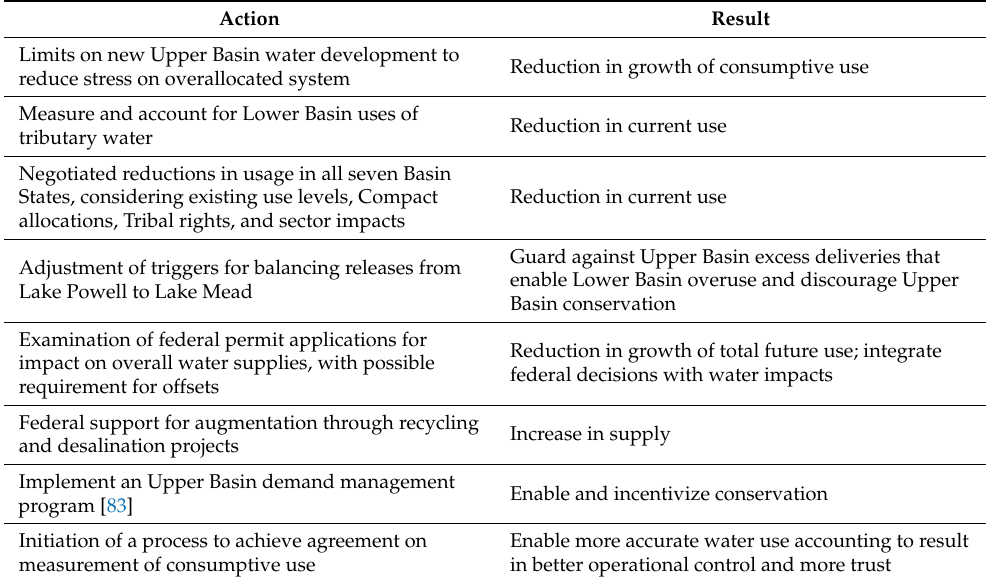
Table 2. Possible actions that require state concurrence (for details, see Supplemental Materials Table